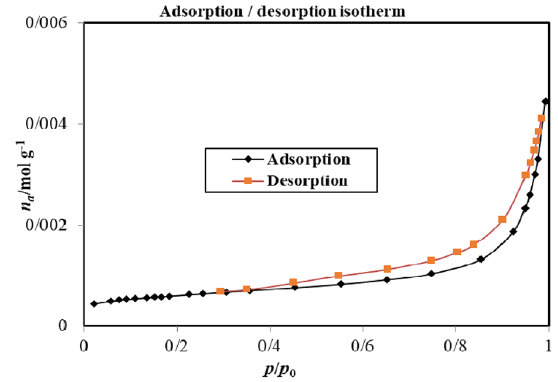
Figure 5. Adsorption/desorption pilot of BiOI@MOF/Z.